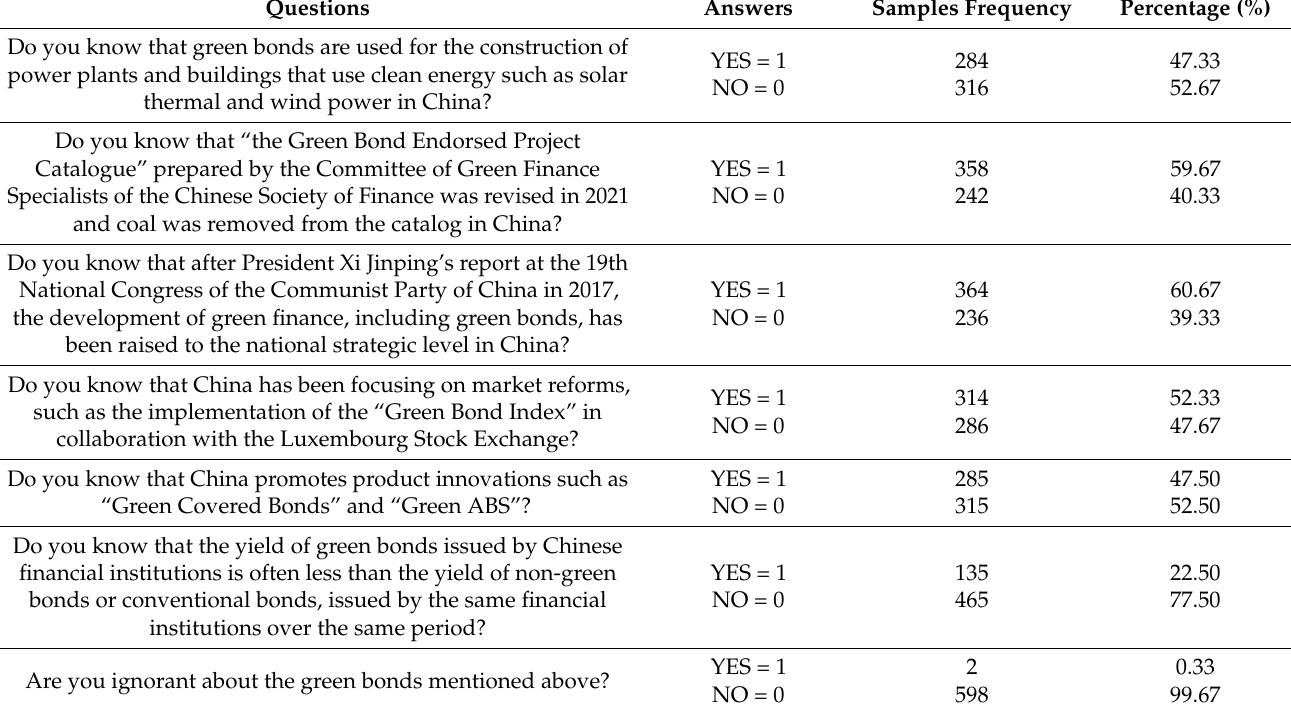
Table 5. Results of the understanding of green bonds ( n = 600).